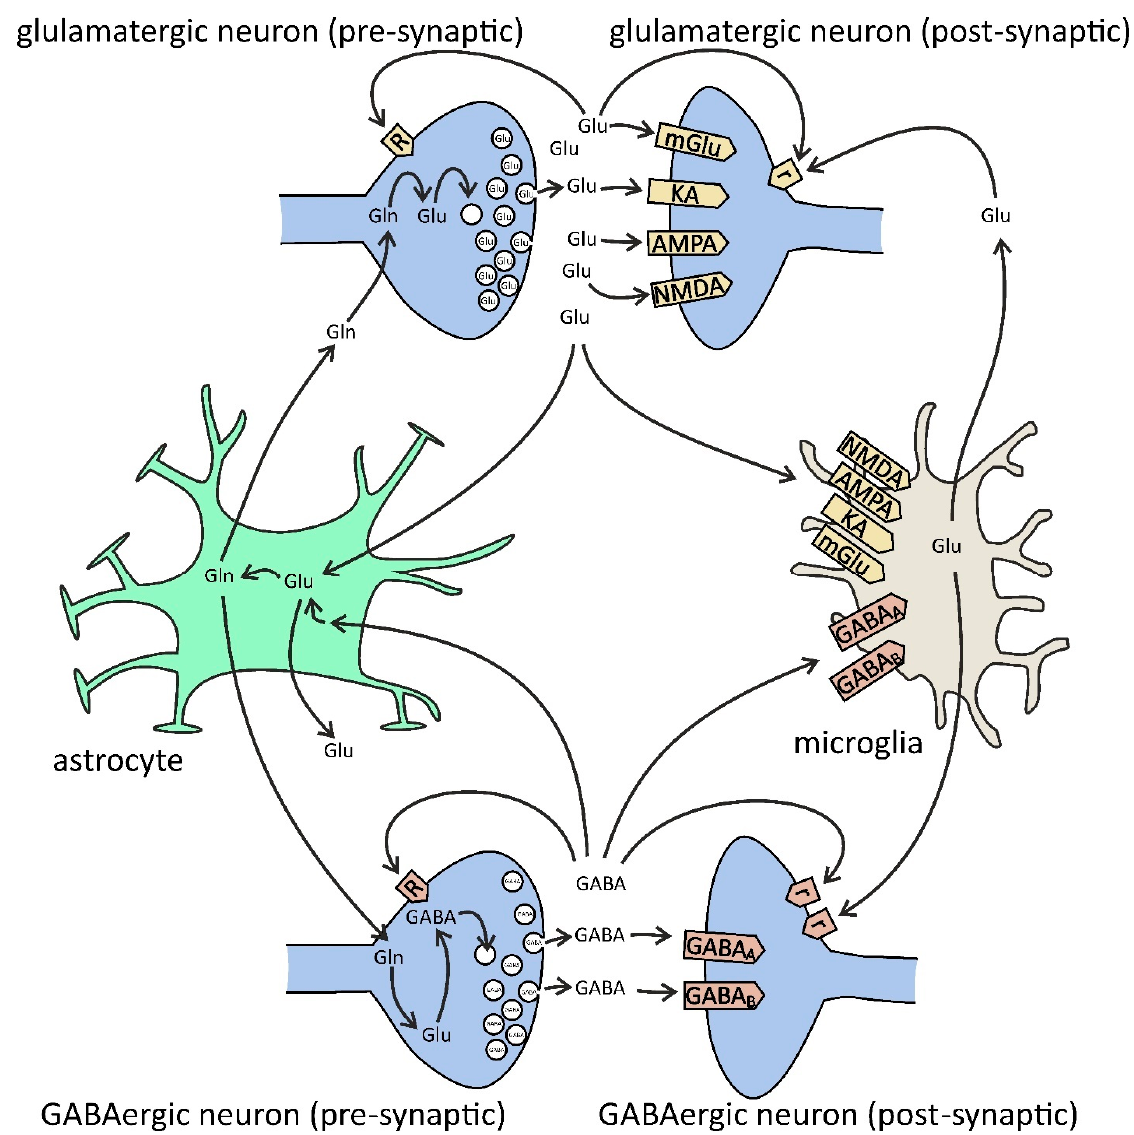
Figure 3. Glutamate (Glu) and GABA in glia–neuron cross-talk. Presynaptic [R] and extrasynaptic [r] receptors. Glutamate is synthesized from glutamine (Gln) by phosphate-activated glutaminase (PAG) and then is packed into synaptic vesicles by vesicular glutamate transporters (VGLUT1/2). After release into the synaptic cleft, glutamate binds to neuronal postsynaptic receptors for glutamate (ionotropic N-methyl-D-aspartate (NMDA), alpha-amino-3-hydroxy-5-methyl-4- isoxazolepropionate (AMPA), kainate (KA), and metabotropic mGluR1/5), to presynaptic receptors (ionotropic NMDA, AMPA, KA, and metabotropic mGluR7), and extrasynaptic receptors (mGluR2/3/4/8), but also to microglial receptors (NMDA, AMPA, KA, and mGluR2–8). Glutamate is also released by microglia via gap-junction hemichannels (e.g., Cx32) and by astrocytes via NMDA and purinergic P2X7 receptors, plasma membrane glutamate transporters, anion transporters, gap-junction hemichannels, and exocytosis. The major uptake of glutamate is performed by astrocytes via excitatory amino acid transporters (EAAT1/2). In astrocytes, glutamate is converted to glutamine by the glutamine synthetase (GS) pathway. Then, glutamine is transferred from astrocytes back to the neurons. GABA is synthesized from glutamate by glutamate decarboxylase (GAD) and then is packed into synaptic vesicles by the vesicular GABA transporter (VGAT). After release into the synaptic cleft, GABA binds to neuronal ionotropic GABA A (pre-, post-, and extrasynaptic), GABA c (pre- and postsynaptic), and metabotropic GABA B (pre-, post-, and extrasynaptic) receptors, but also to microglial GABA A/B . Both presynaptic nerve terminals and surrounding glial cells are responsible for the uptake of GABA from extracellular space. In glia, GABA is converted to glutamine, and then it is transferred back to the neurons and converted to glutamate, and finally to